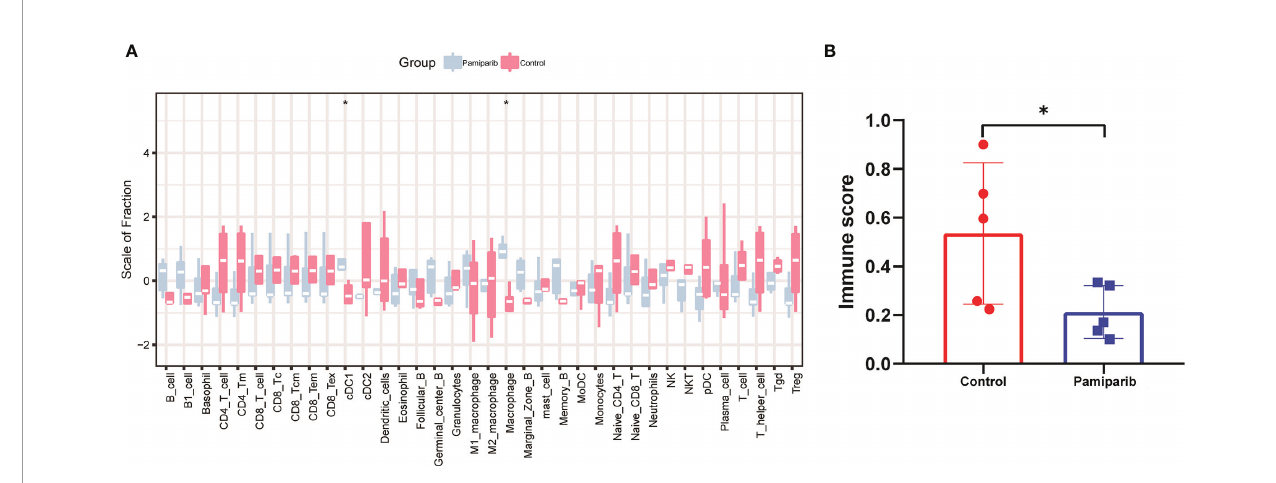
FIGURE 2 | Bioinformatic analysis of RNA-seq dataset from a Pan-02 allograft tumor model treated with parmiparib. (A) Spectrograms of 22 immune cell expressions in 2 different groups. Control, control group; pamiparib, pamiparib monotherapy group. (B) Histogram of immune scores between the 2 groups. Control, control group; pamiparib, pamiparib monotherapy group. Data are mean ± SD; n = 5 samples per group. Data analysis was performed by unpaired t -test. * P <